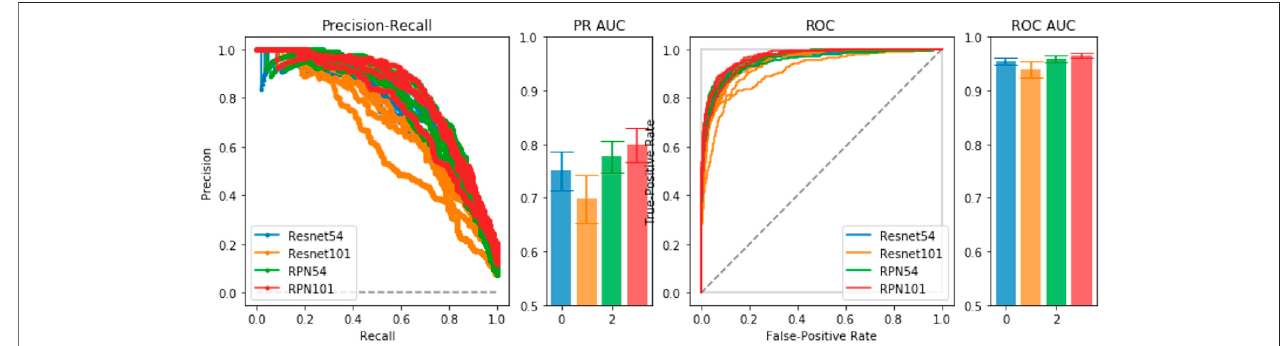
FIGURE 2 | Model Selection. We compared ResNet-54, ResNet-101 and a joint prediction and region-proposal model architecture (RPN) based on the ResNet model. Under Precision-Recall and the Receiver Operating Characteristic, the joint predictors RPN54 and RPN101 both signi fi cantly outperformed their baseline counterparts with signi fi cance. We chose RPN54 as the feature extractor for the full LatentCADx model.